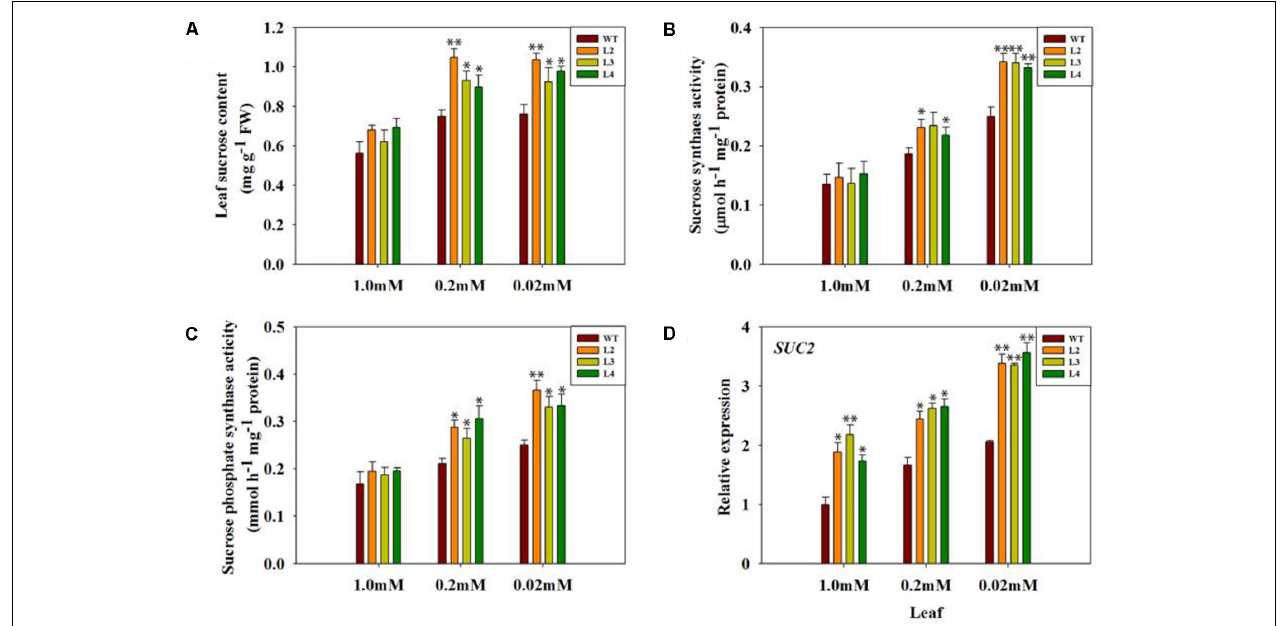
FIGURE 3 | Sucrose concentration (A) , SS and SPS activity (B,C) and leaf SUC2 gene expression (D) in WT tomato plants and three codA -transgenic tomato lines under variable Pi conditions. Seedlings (after germination) were treated with 1.0 mM phosphorus (CK), 0.2 mM phosphorus and 0.02 mM phosphorus (LP) for 15 days under sand-culture system. The seedlings were subsequently used for experimental analysis. Values represent means ± SD of three replicates. Asterisks indicate significant differences compared with WT plants (Student’s t -test). SS, sucrose synthesis; SPS, sucrose phosphate synthesis; FW, fresh weight; ∗ P < 0.05; ∗∗ P < 0.01.